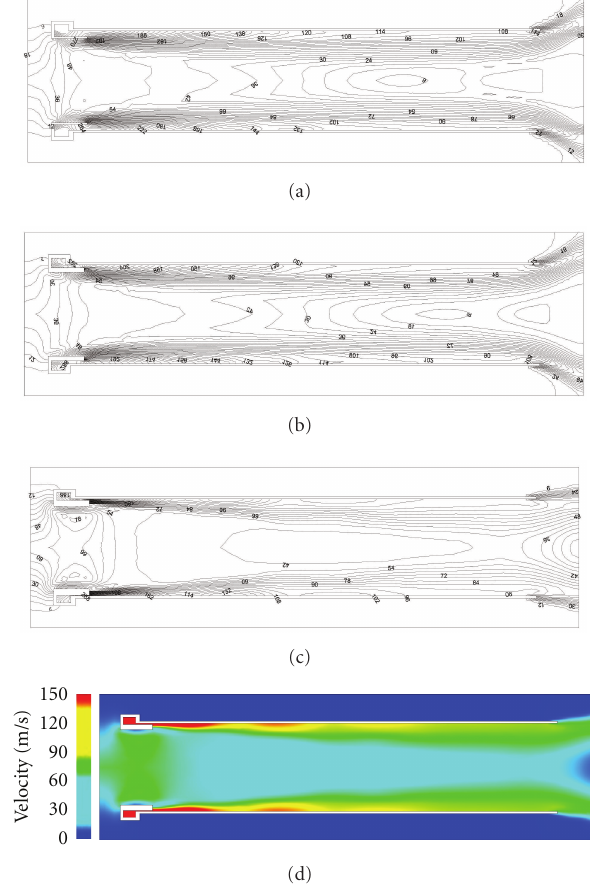
Figure 8: Isolines of the total velocity V. (a) δ = 12 mm; (b) δ = 6mm; (c) δ = 2 . 5 mm; (d) δ = 2 . 5